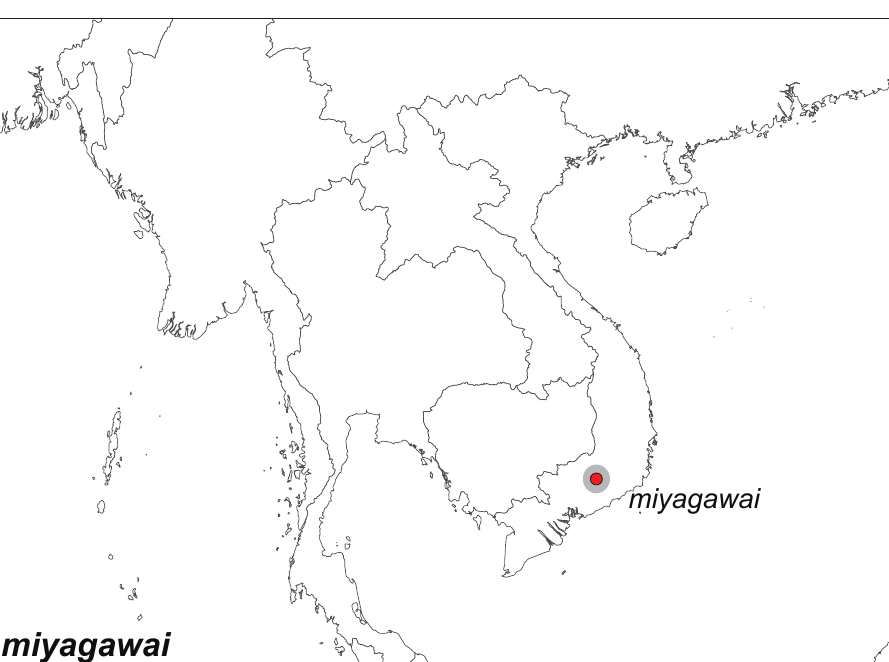
Figure 49. Distribution map of Elymnias congruens .